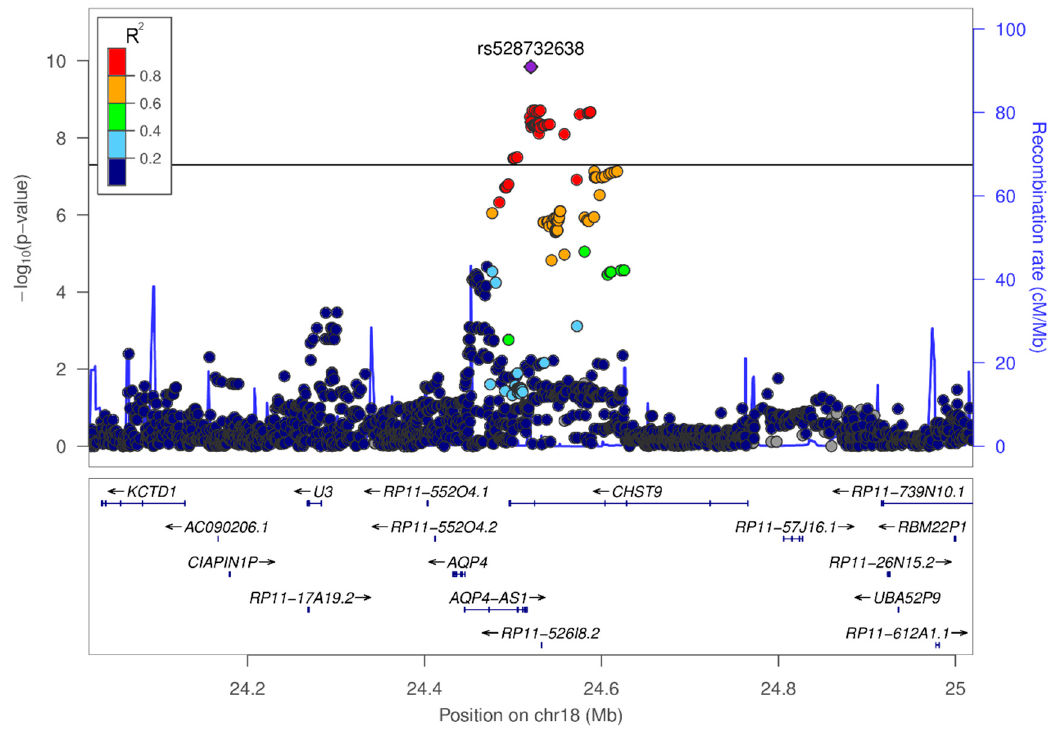
Figure 3. Variant rs528732638 on chromosome 18q11.2 reached genome-wide significance.